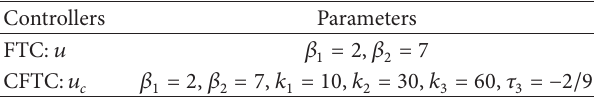
Table 1: Control parameters for the numerical Example (43). Controllers Parameters FTC: